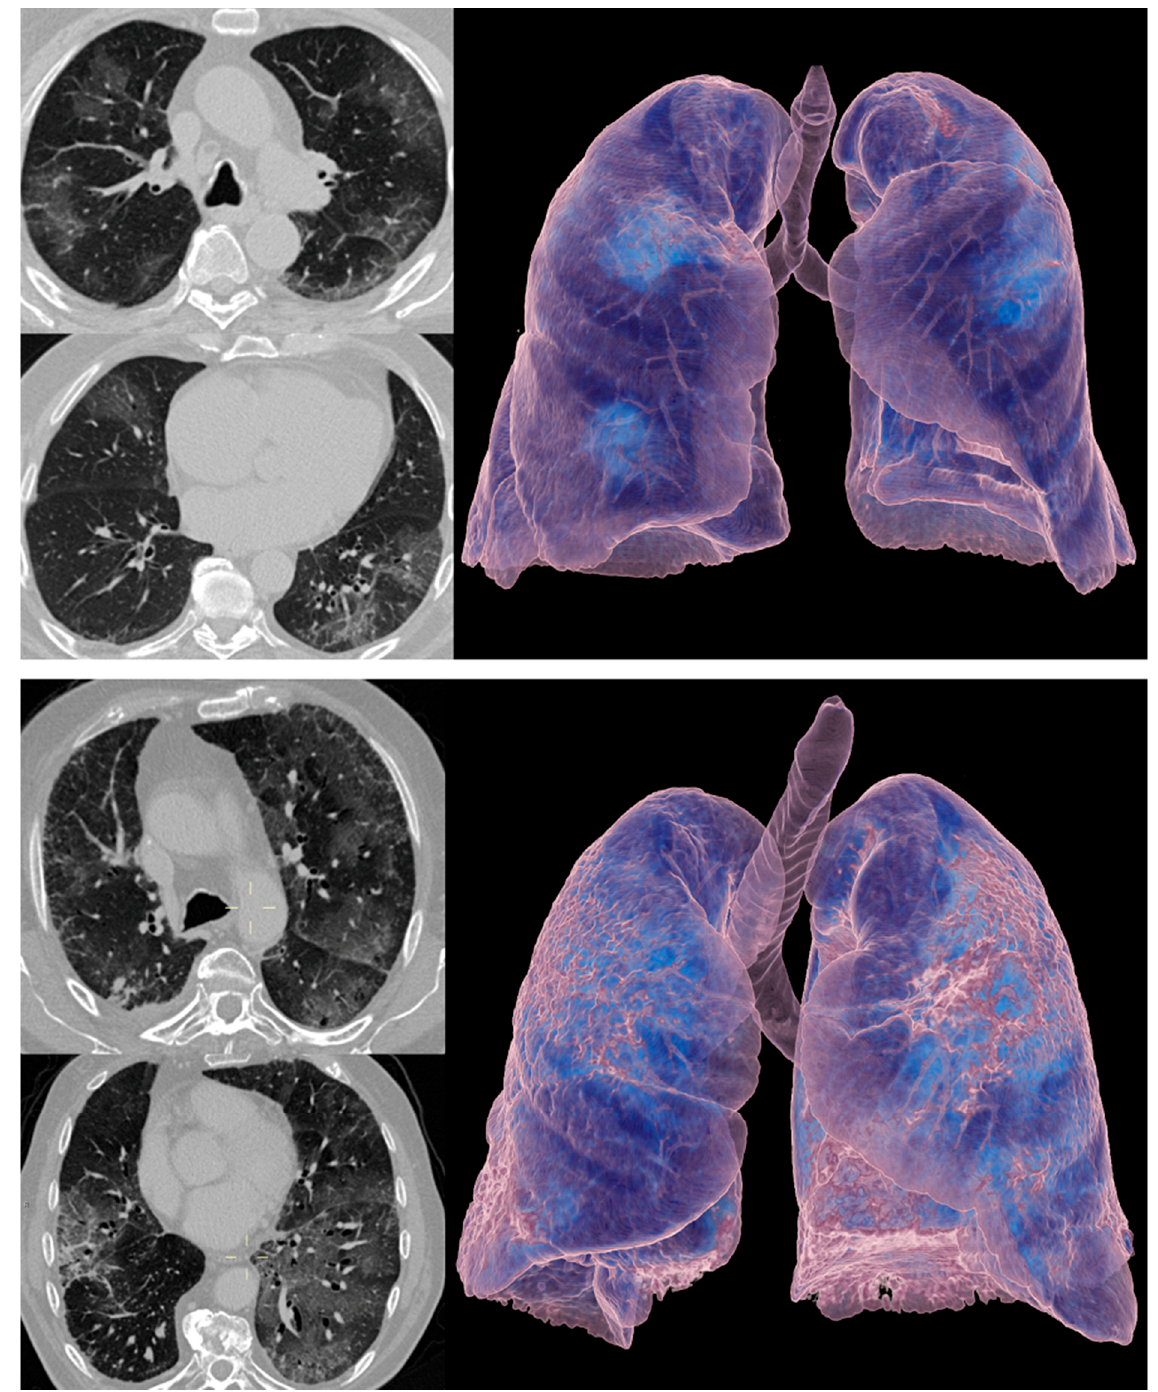
Figure 3. Computed tomography (CT) images of patients with RT-PCR-proven COVID-19 pneumonia (upper panel) and ICI therapy-related pneumonitis (lower panel). Axial CT images with lung window (left side of upper and lower panel) and 3D volume rendering technique (VRT) images (right side of upper and lower panel) are shown. Note the overlapping CT features of ground-glass opacities between the two cases of different etiology.